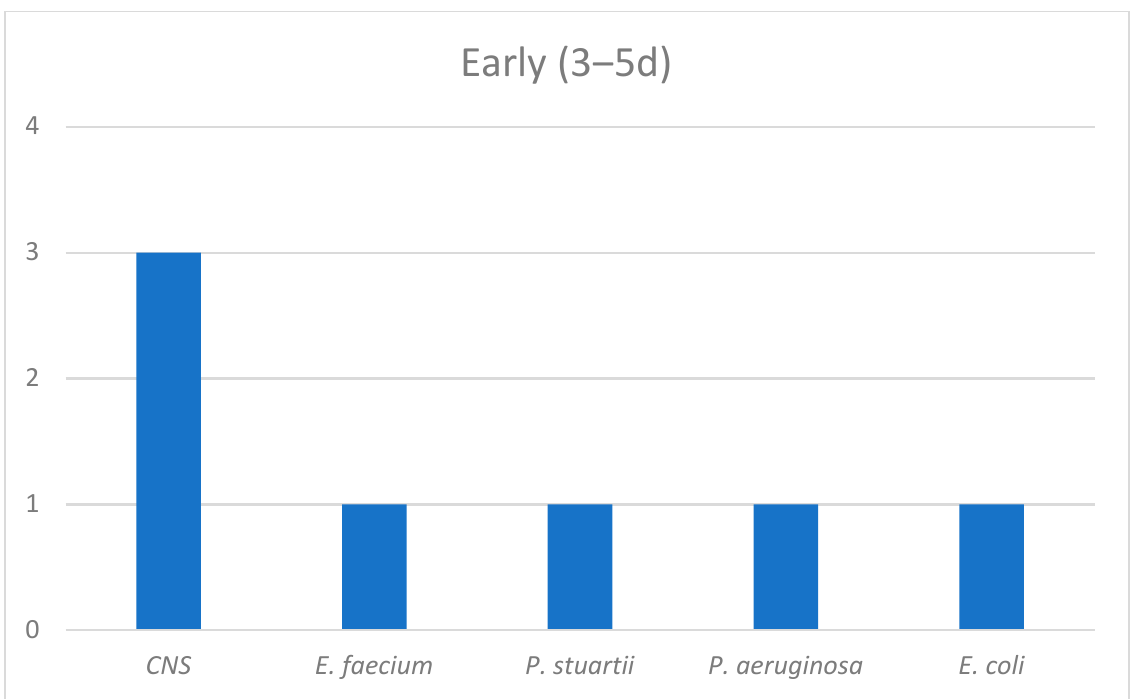
Figure 2. CA infections group Epidemiology.